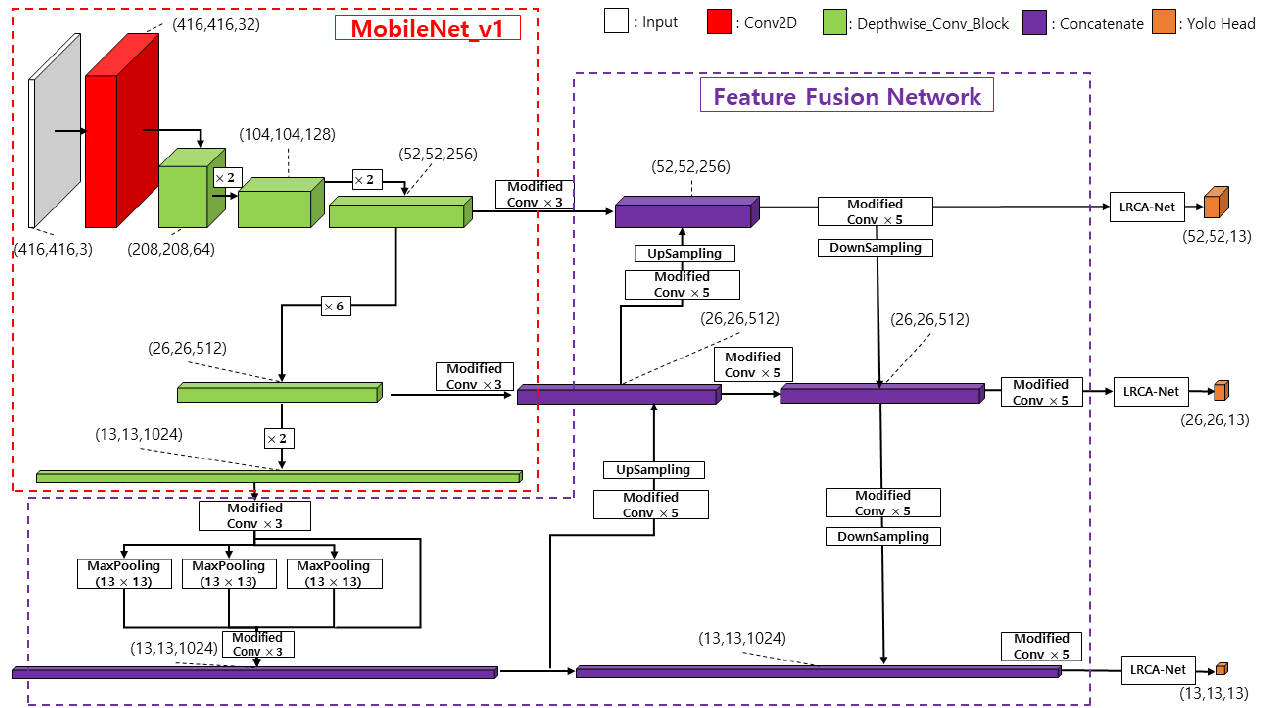
Figure 10. The parameters of each improved model are compared with the original model.